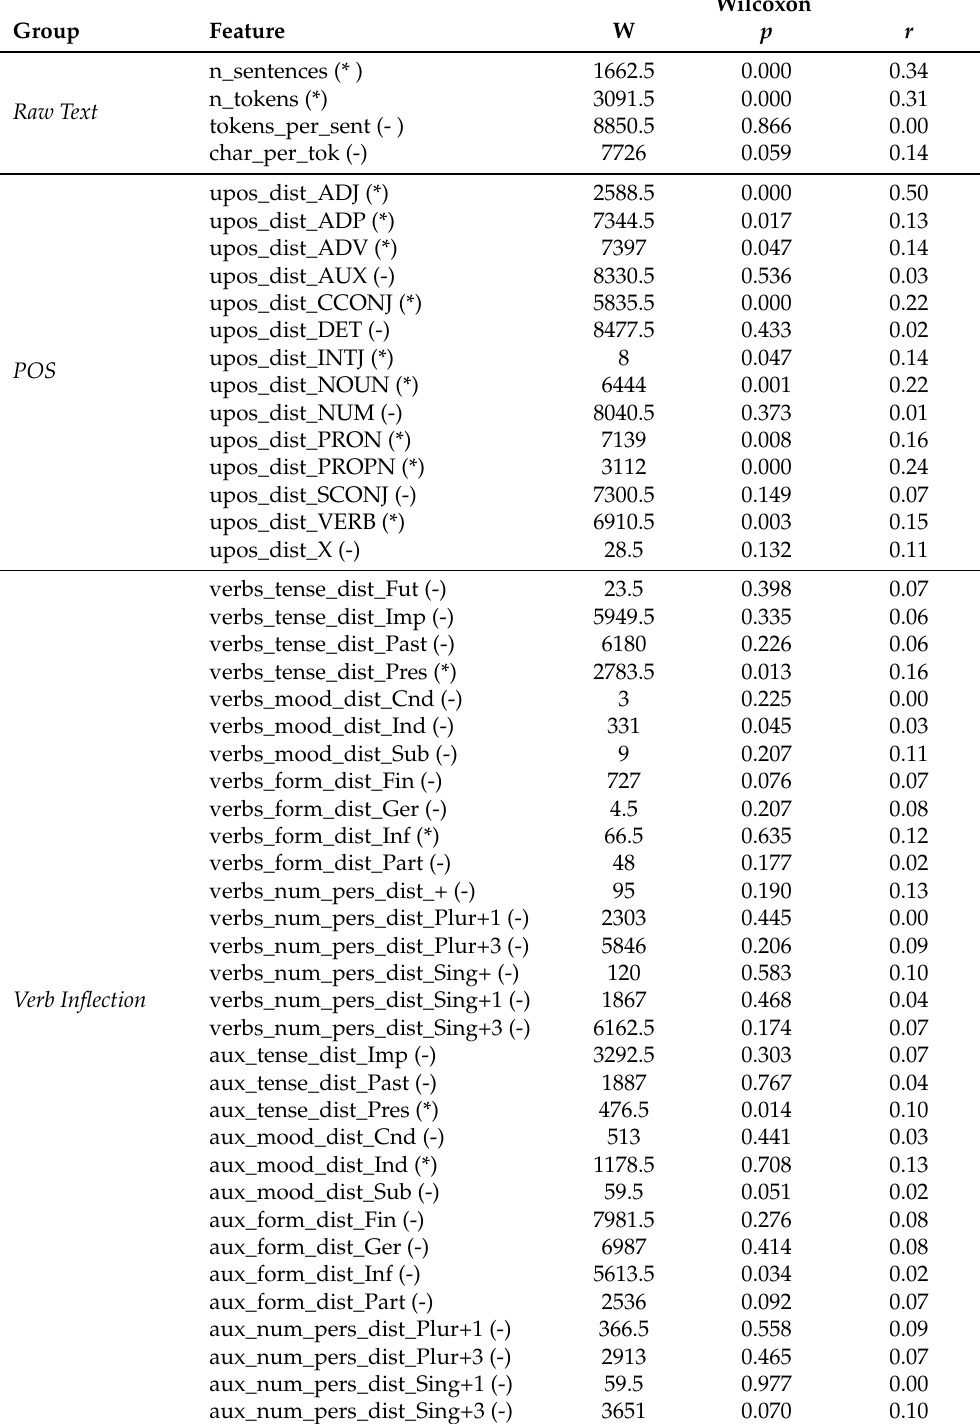
Table A1. For each linguistic feature, we report the W score of the Wilcoxon signed-rank test ( ‘W’ ) computed for the feature values obtained on retellings of T and SD, the p -value ( ‘p’ ), and the effect size score ( “r” ). Features that show a significant variation ( p < 0.05) between the two corpora are marked as “(*)”; non-significantly varying features are marked as